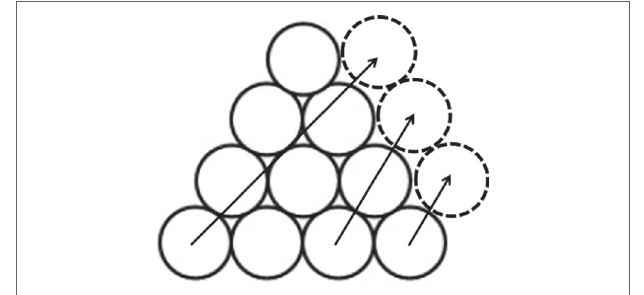
FIGURE 2 | An example of one participant’s